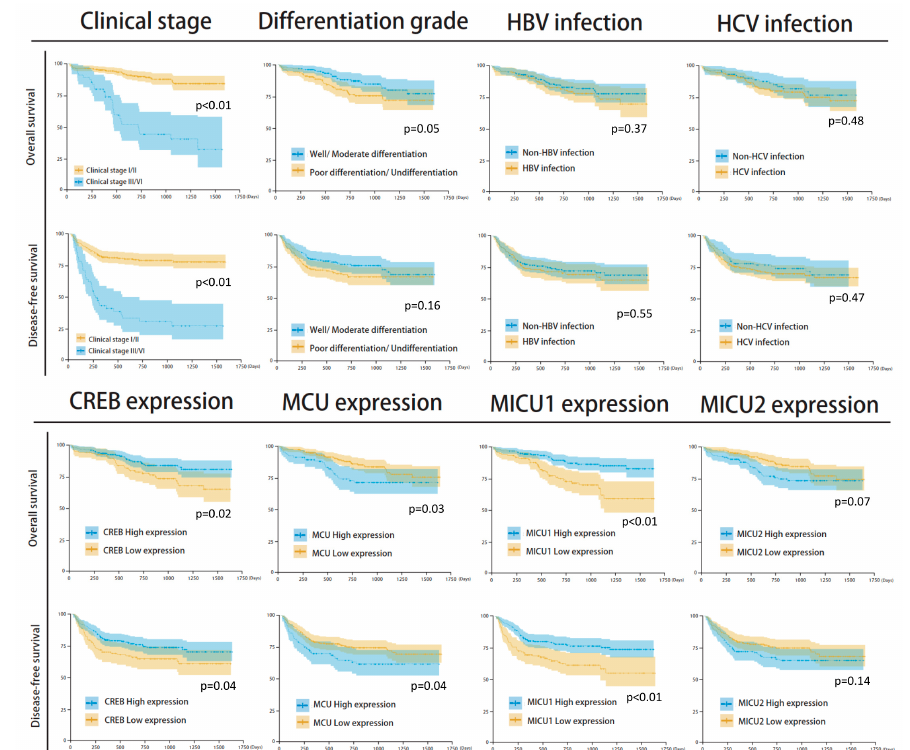
Figure 4. Kaplan–Meier analysis of clinicopathological parameters, including clinical stage, differential histologic grade, hepatitis B virus (HBV) infection, hepatitis C virus (HCV) infection, expression of CREB, MCU, MICU1, and MICU2 gene.